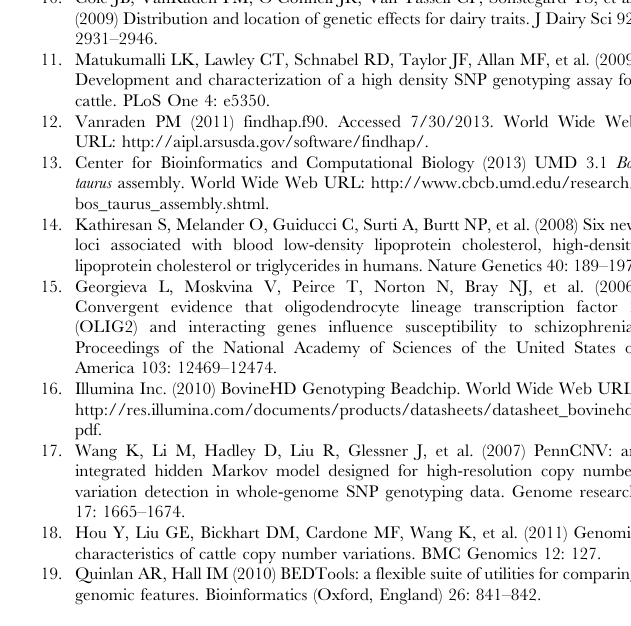
Table S1 Information on exome sequenced animals.